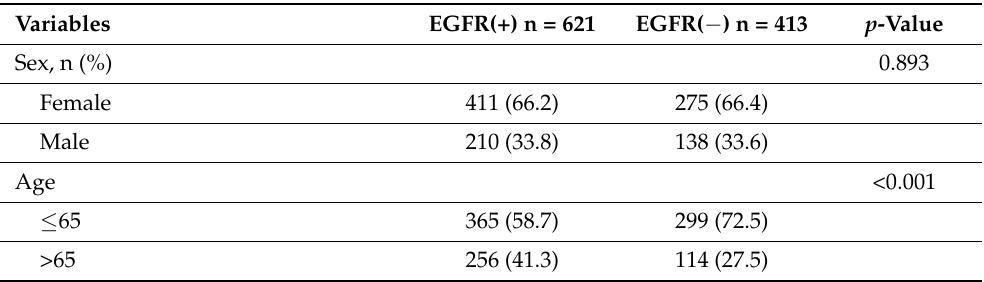
Table 1. Patients clinicopathological